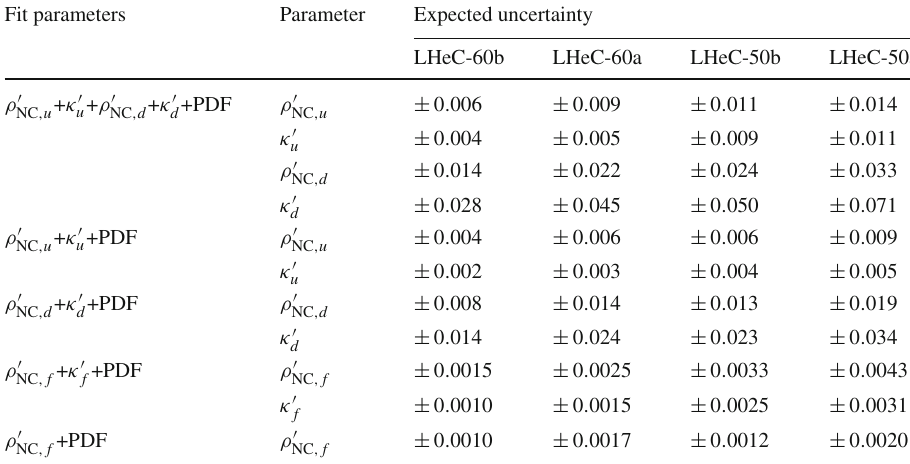
Fig. 12 Expectations at the 68% confidence level for the simulta- neous determination of anomalous up- and down-type quark cou- plings, assuming electron couplings fixed at their SM value. In the left panel, for up-type quarks, the results are compared with uncertain-